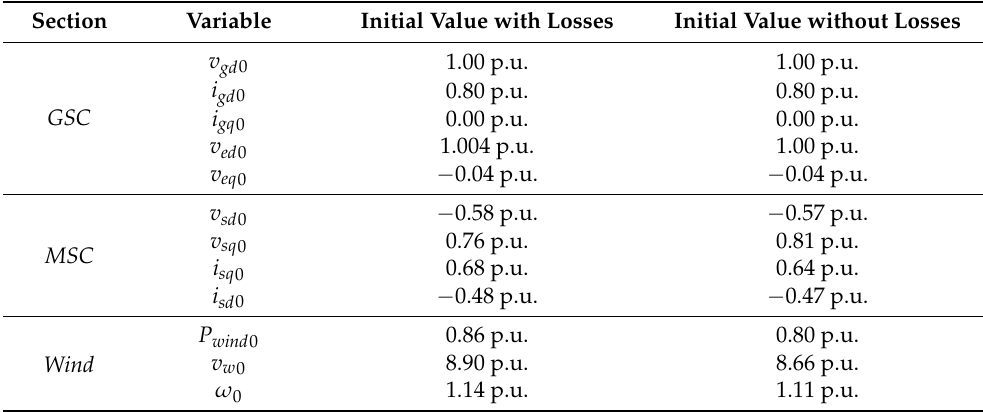
Table 2. Comparison of the initialization results for the traditional lossless initialization and the proposed one (that accounts for the WTG losses).